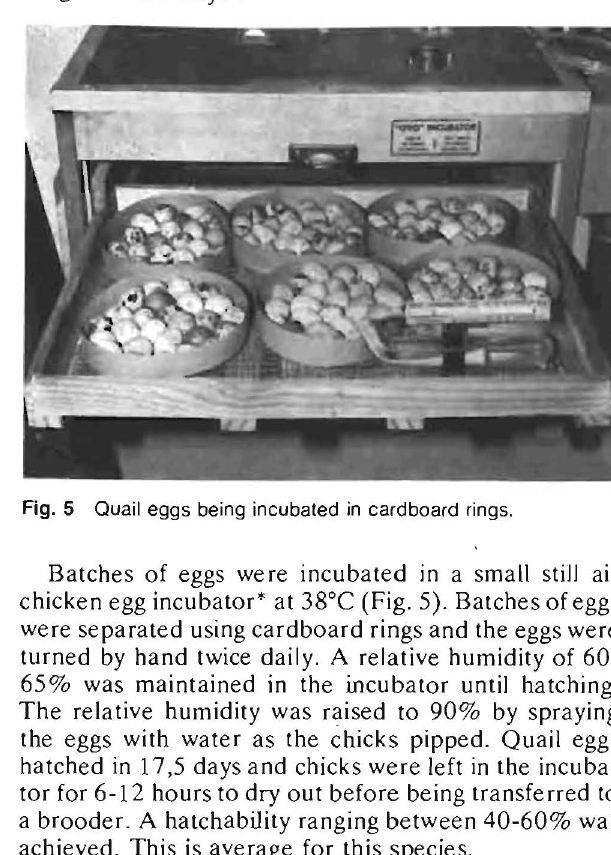
achieved. This is average for this species.